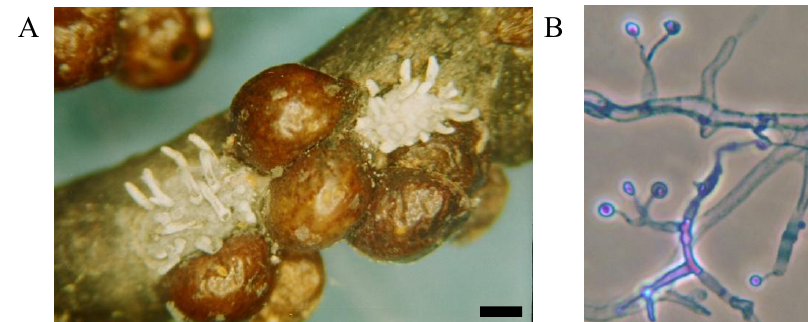
Figure 5. European fruit lecanium infected with the fungus Hirsutella lecaniicola ( A ); mature culture of fungus on nutrient medium, phase contrast, cotton blue stain, objective ×100 ( B ). (Bar = 0.5